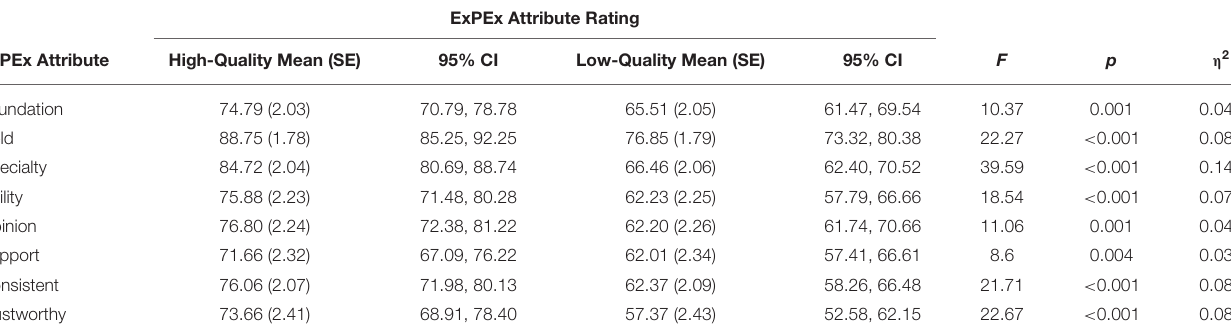
TABLE 7 | Table of marginal means and inferential statistics for expert persuasion expectancy (ExPEx) attributes by evidence quality